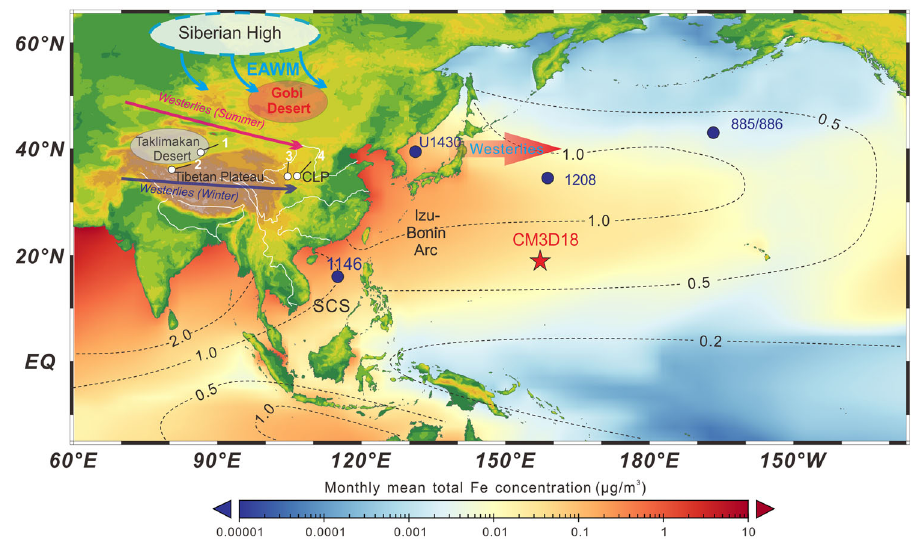
Fig. 1 Schematic atmospheric circulation and locations of key records (modi fi ed from Wan et al. 65 ). The major contribution of Asian dust to the North Paci fi c is indicated by monthly mean total iron concentrations ( μ g m − 3 ) based on Earth system modeling (color spectrum) and dust fl uxes to the oceans (g cm − 2 a − 1 ) (dotted lines) 66,67 . Marine records include crust CM3D18 in the western Paci fi c Ocean (this study), IODP Site U1430 in the Sea of Japan 22 , ODP Site 1146 in the South China Sea (SCS) 32,49 , and ODP Site 885/886 13,23 and ODP Site 1208 9,68 in the North Paci fi c. Terrestrial records include the sediment core from Lop Nor (No. 1) 40 and loess deposits (No. 2) 12 in the Tarim Basin of western China, and loess pro fi les from Baishui (No. 3) 46 and Lingtai (No. 4) 48 in the Chinese Loess Plateau (CLP). The shaded areas in the Asian interior are potential source regions of Asian dust in the Taklimakan Desert (China) and the Gobi Desert (Mongolia). Arrows indicate wind directions for the East Asian Winter Monsoon (EAWM; light blue) and the prevailing westerlies (dark blue arrow over land for winter; pink arrow over land for summer; thick red arrow over the ocean) 69 . The locations of the July and January jet streams are from Ishizaka 6